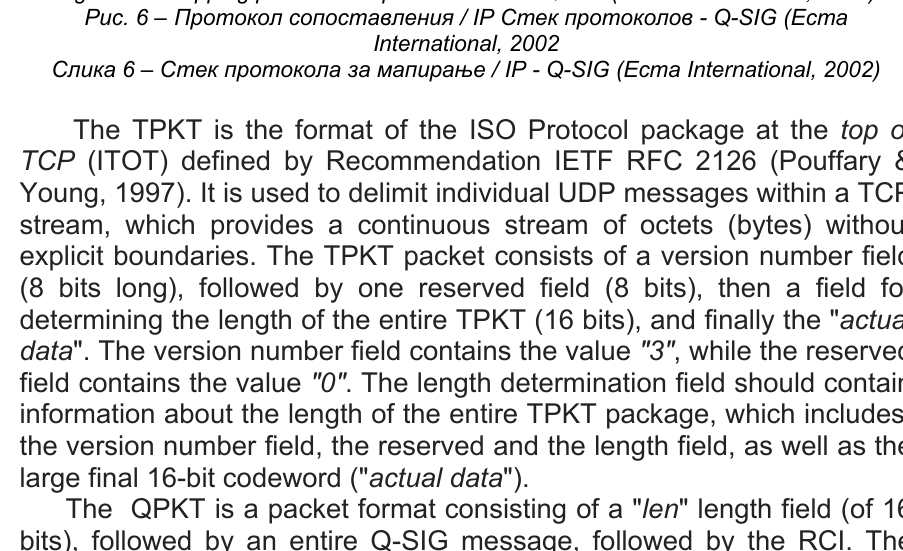
Figure 6 – Mapping protocol / IP protocol stack - Q-SIG (Ecma International, 2002) Рис . 6 – Протокол сопоставления / IP Стек протоколов - Q-SIG